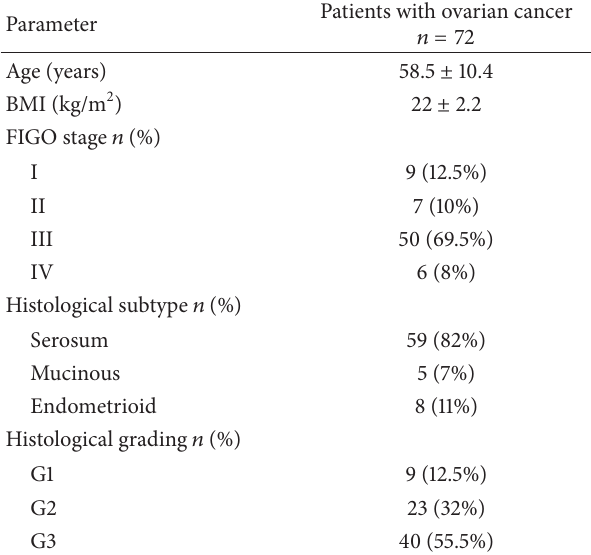
Table 1: Baseline characteristics of the study